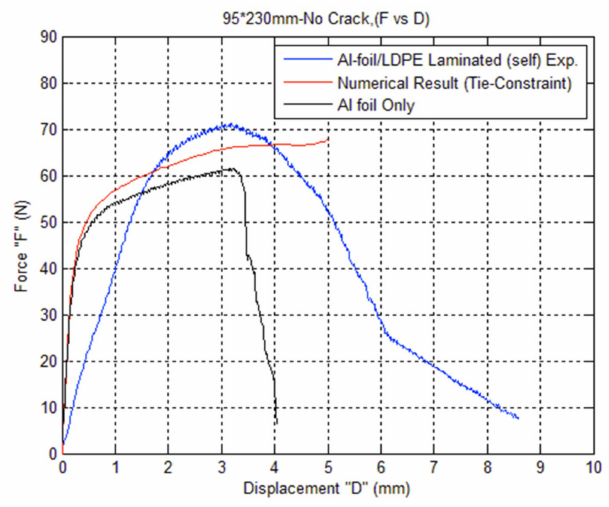
Figure 18. Comparison of experimental and numerical analysis.